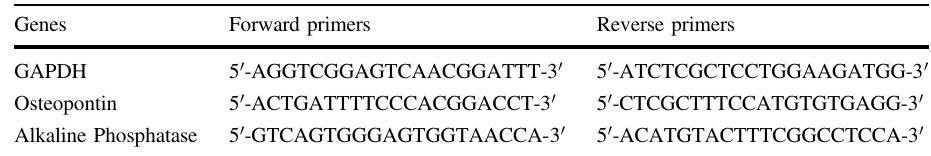
Table 1 Forward and reverse primers sequences used for RT-